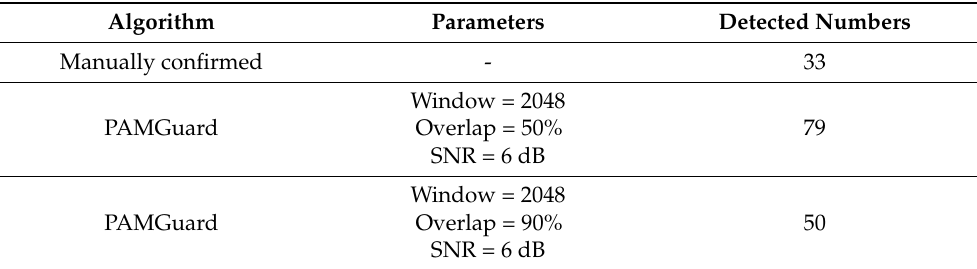
Table 2. Comparison of results.